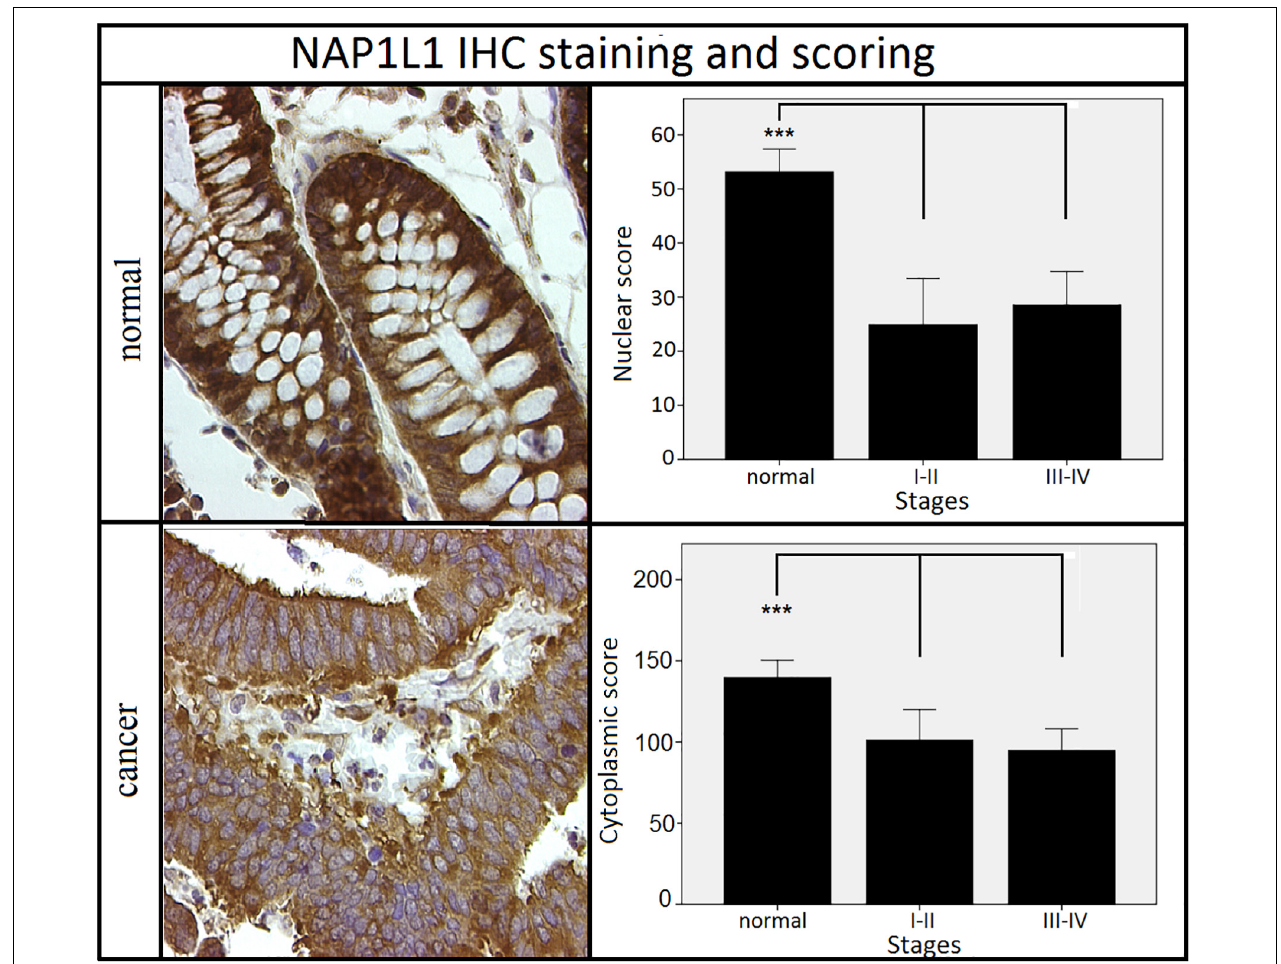
FIGURE 4 | Staining patterns and scoring results for NAP1L1. NAP1L1 nuclear and cytoplasmic scores were decreased in the cancer groups when compared to normal adjacent tissues. No difference was observed between different stages of cancer. *** p < 0.001 (Kruskal–Wallis test followed by post hoc Dunn-Bonferroni test for pair-wise comparisons). Error bars: ± 2 SE. Sample numbers: normal = 32, stages I–II = 11, stages III–IV = 21. Magnification: 630 ×